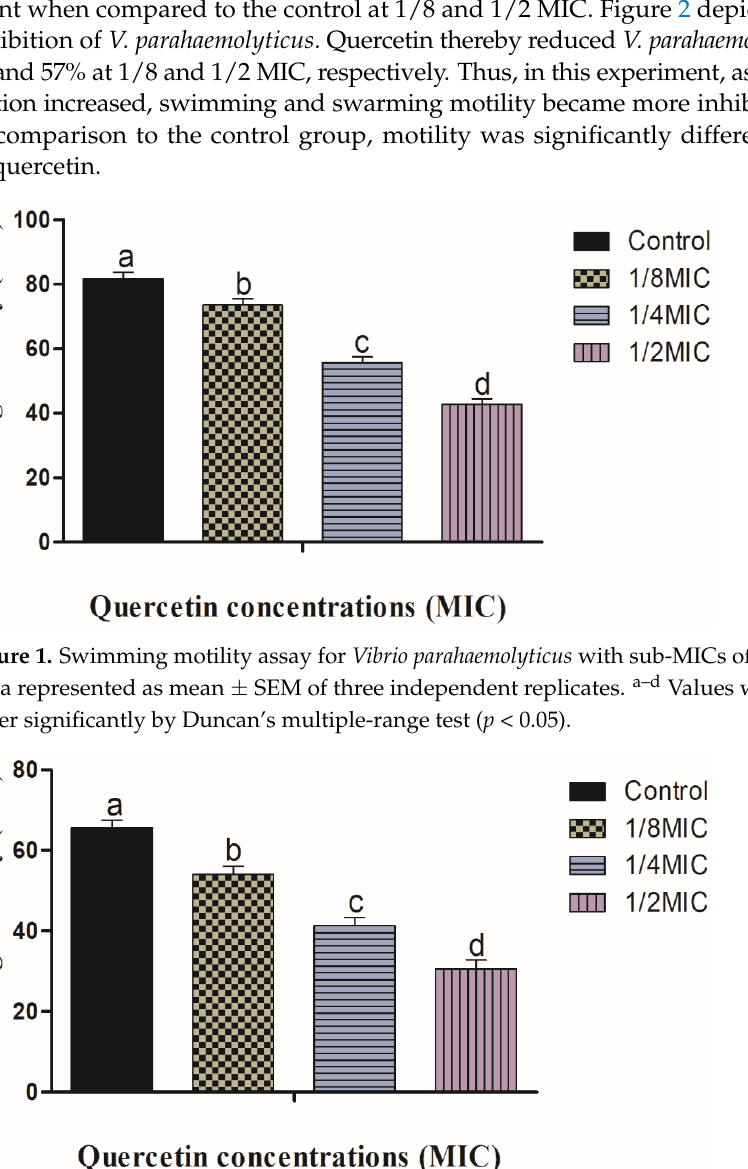
Figure 2. Swarming motility assay for Vibrio parahaemolyticus with sub-MICs of quercetin (µg/mL). Data represented as mean ± SEM of three independent replicates. a–d Values with different letters differ significantly by Duncan’s multiple-range test ( p <